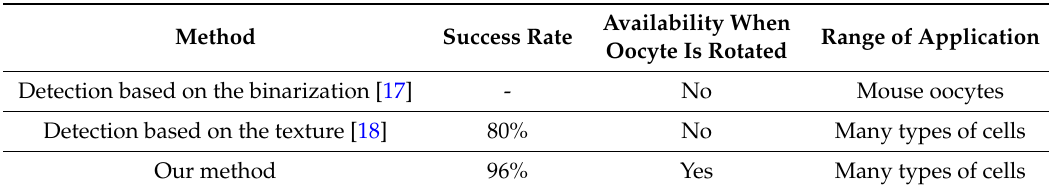
Table 6. Comparison of